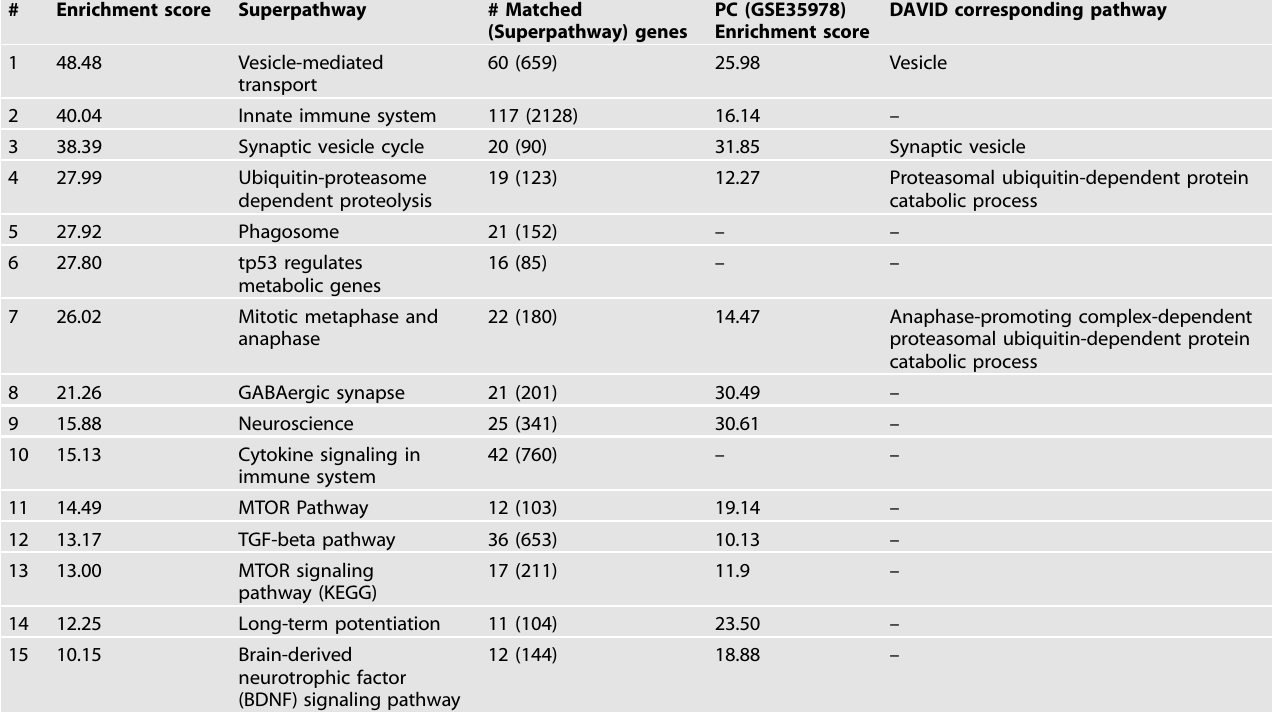
Table 2. Pathway enrichment analysis results of interest for 800 extended GWAS-based genes of the hippocampus (HPC)